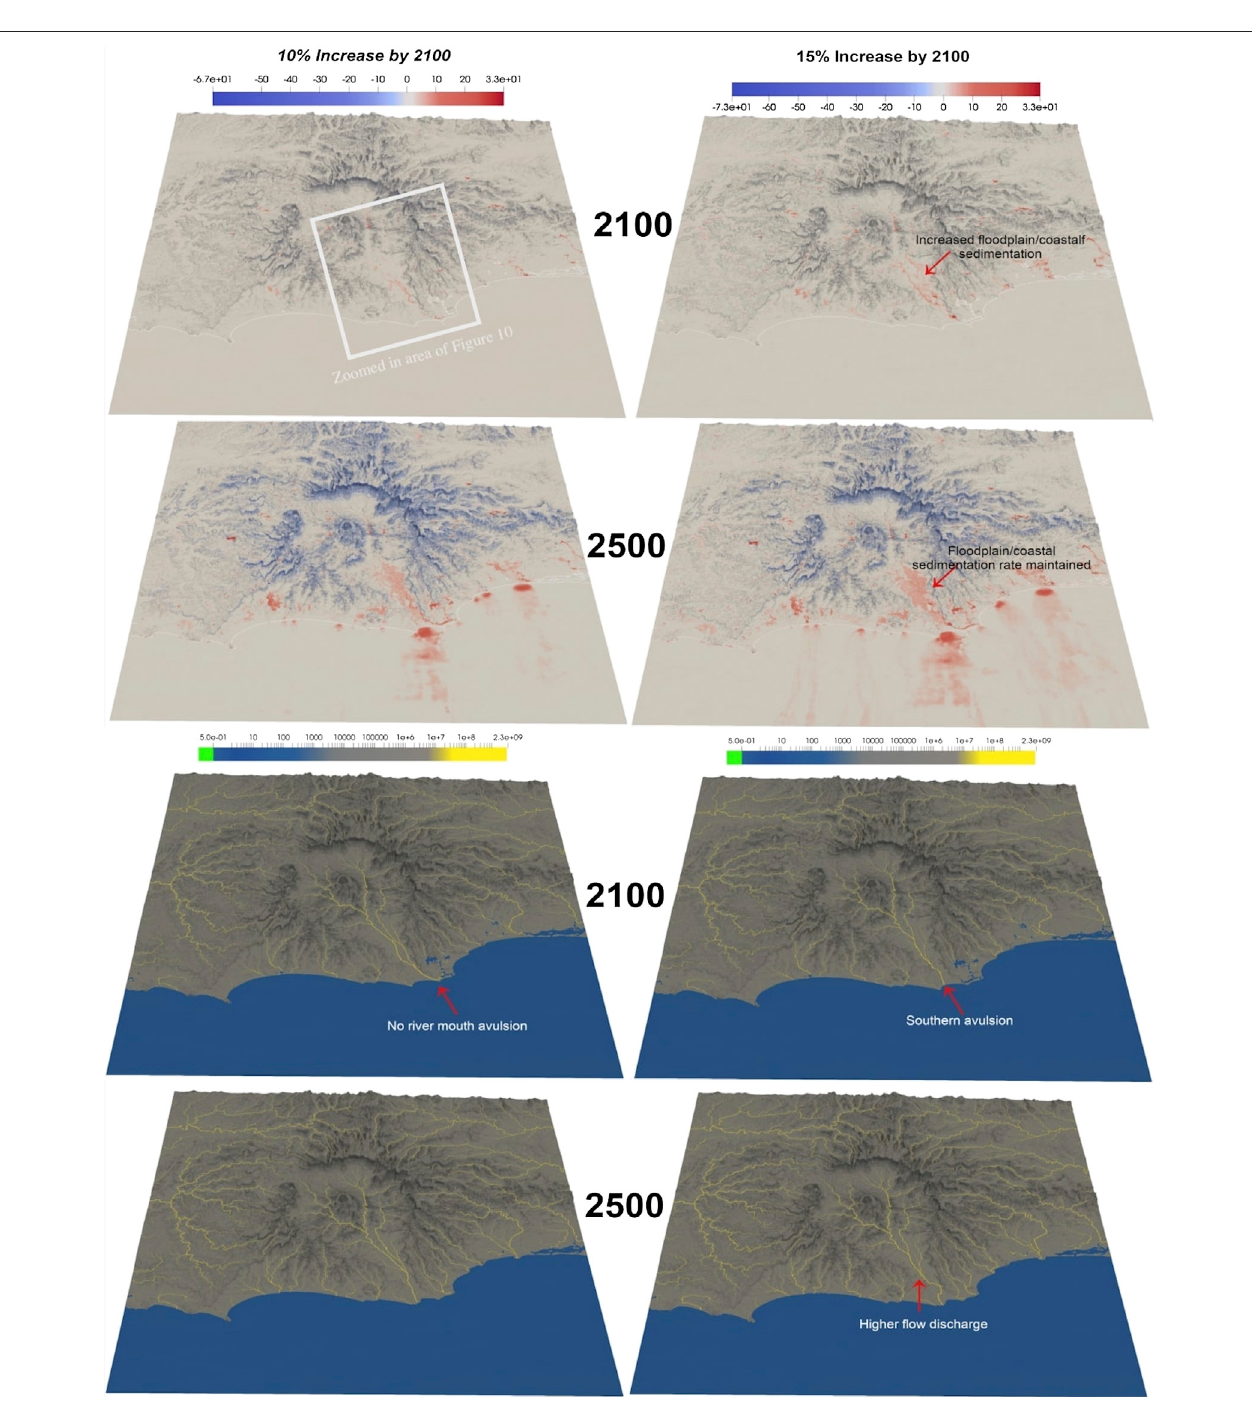
FIGURE 11 | Comparison of precipitation scenarios: +10% (left) and +15% (right) . Visualizations of erosion/deposition with red areas indicating deposition and blue areas indicating erosion (m 2 /a) (top) and visualizations of discharge with brighter yellow colors indicating greater discharge rates (m 2 /a) (bottom) , illustrating the erosional, depositional and landscape dynamics from 2100 – 2500.